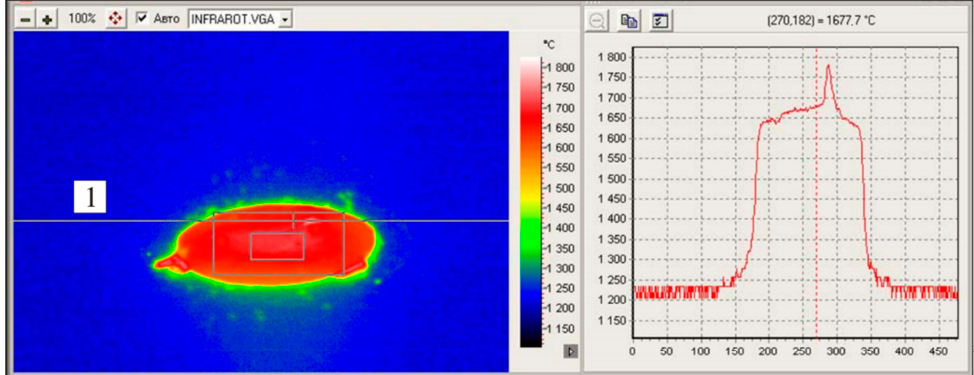
Figure 6. Temperature distribution over the area of the CCCM sample with a protective SiC coat- ing.